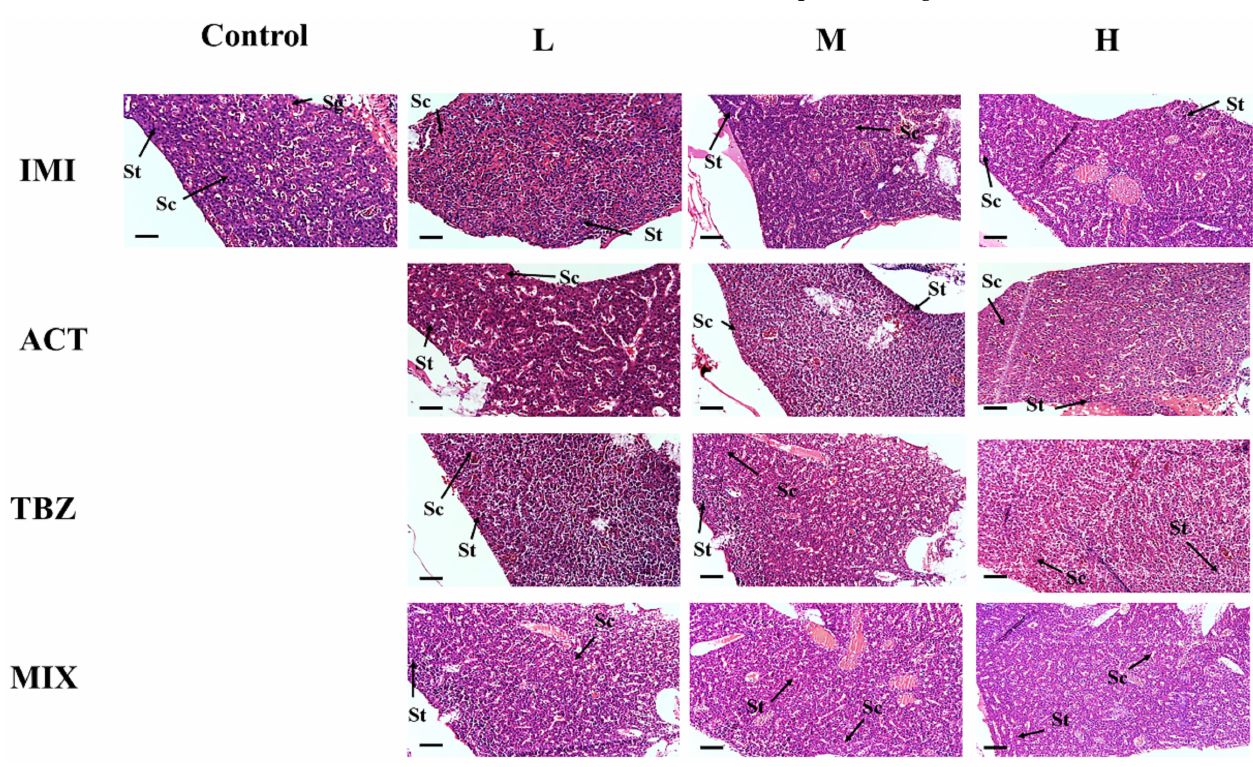
Figure 3. Histology microphotographs of the testes of F0 zebrafish after 28 d exposure. The cells of the testes mainly included spermatocytes (Sc) and spermatids (St), (200 magnification). Scale bar = 100 µ m. Here L: low concentration, M: medium concentration and H: high concentration. The histology microphotographs of the ovaries showed that the cells of the ovaries were mainly composed of cells in early vitellogenic oocytes (EV) and late vitellogenic oocytes (LV) in the control group, in contrast, the amount of EV and LV decreased in the individual and combined exposure groups. With the increase in concentration, vacuolar damage was observed in the oocytes, and this was more obvious in the combined exposure group (Figure